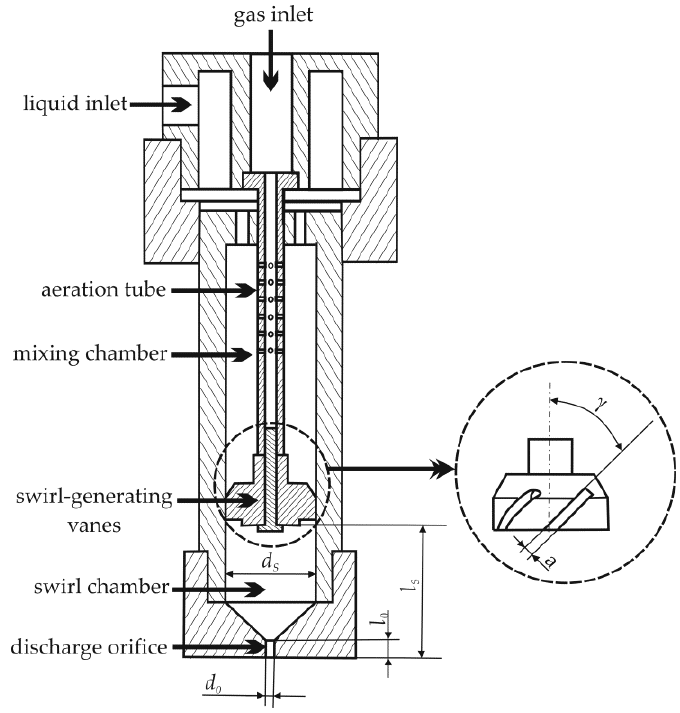
Figure 4. Design of a two-phase atomizer with a swirl insert [52].